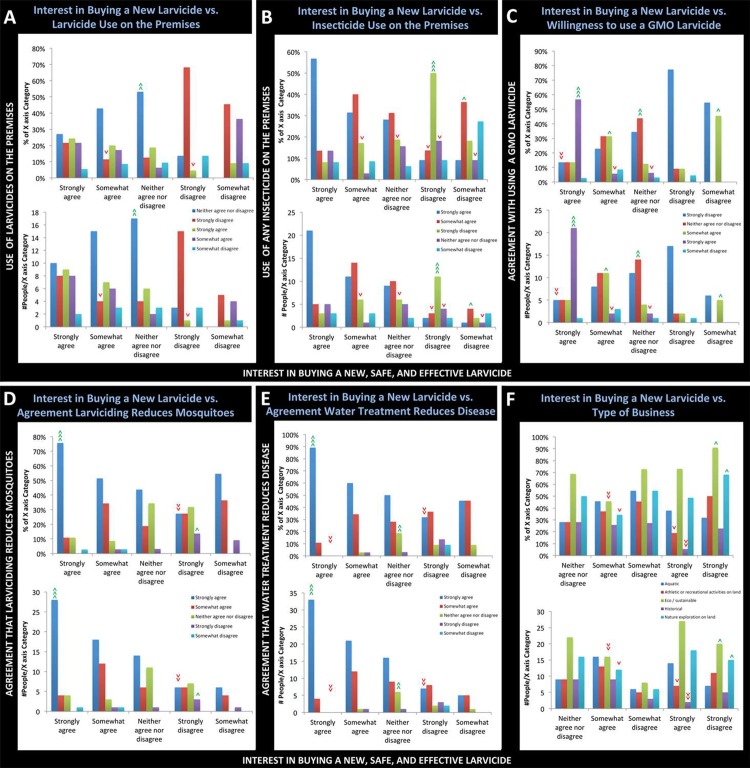
Analysis of respondents willing or not willing to purchase a new larvicide for use on the premises.Likert-scale responses to the question of whether the business is interested in purchasing a new larvicide for use on the premises (X-axes) vs. A) Willingness to use larvicides on the premises, B) Willingness to use any insecticides on the premises, C) Willingness to use a GMO-larvicide if it is shown to be safe and effective, D) Agreement that larvicide use will reduce the number of mosquitoes, E) Agreement that treatment of water where mosquitoes breed will reduce disease, and F) Respondent-provided description of the type of business. The percentages (upper graph in each panel) and numbers (lower graphs) of the X-axis category respondents providing the indicated answers are shown. >>> = very highly significant, >> = very significant, > = significant, with green representing a higher than expected percentage/number for a given X-axis category and red representing a lower than expected percentage/number of respondents for the indicated X-axis category. Additional details regarding the statistical analyses and further discussion of significant results are provided in the text.